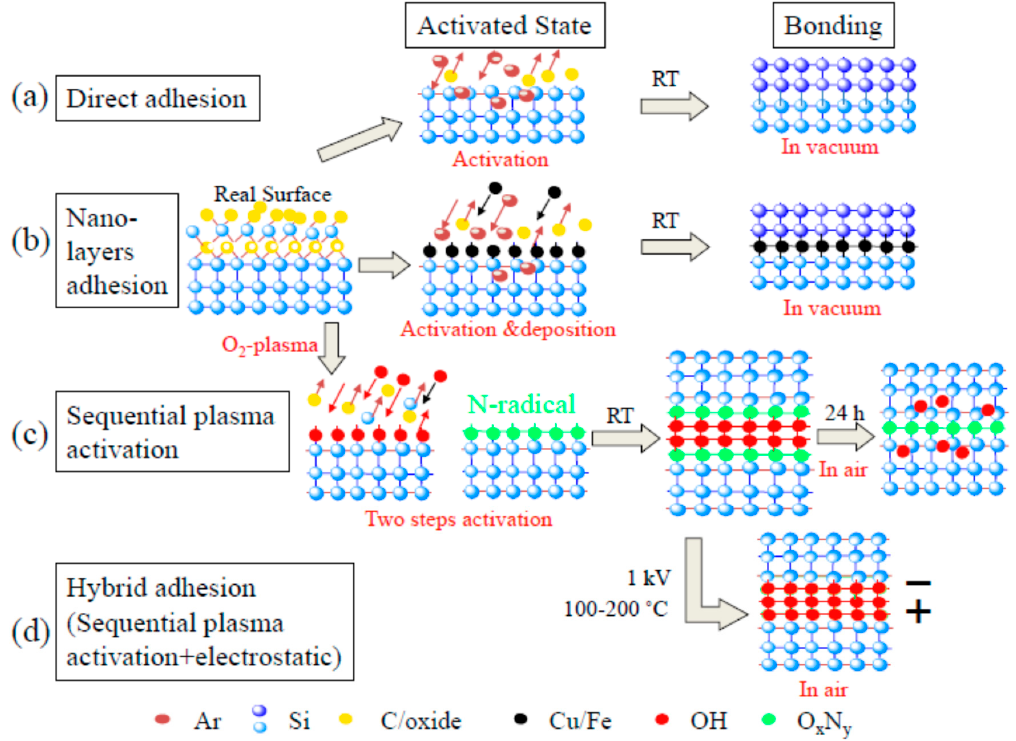
Figure 4. Surface-activated bonding of heterogeneous materials [103].